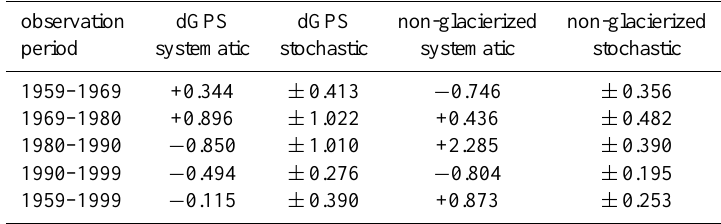
Table 3. Systematic and stochastic uncertainties of the ice thickness changes at Storglaci¨aren. The uncertainties (in meter ice thickness) are based on a comparison with 26 independent dGPS measurements and a comparison of DEM changes in non-glacierized terrain ( n = 523). For details see text.